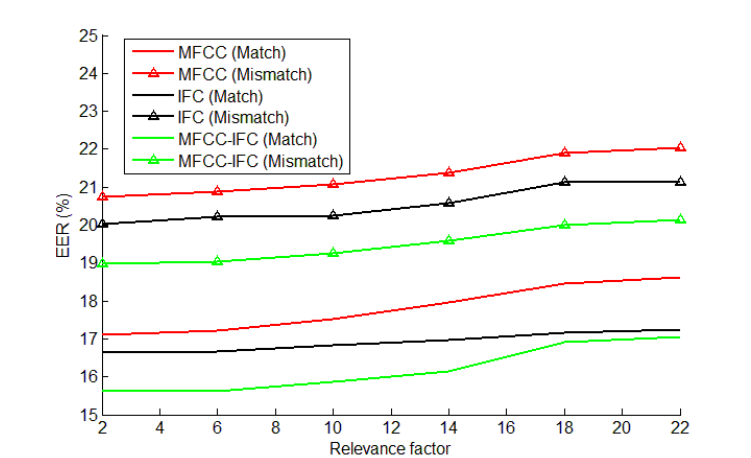
Figure 7. The effect of the relevance factor on system recognition performance in terms of